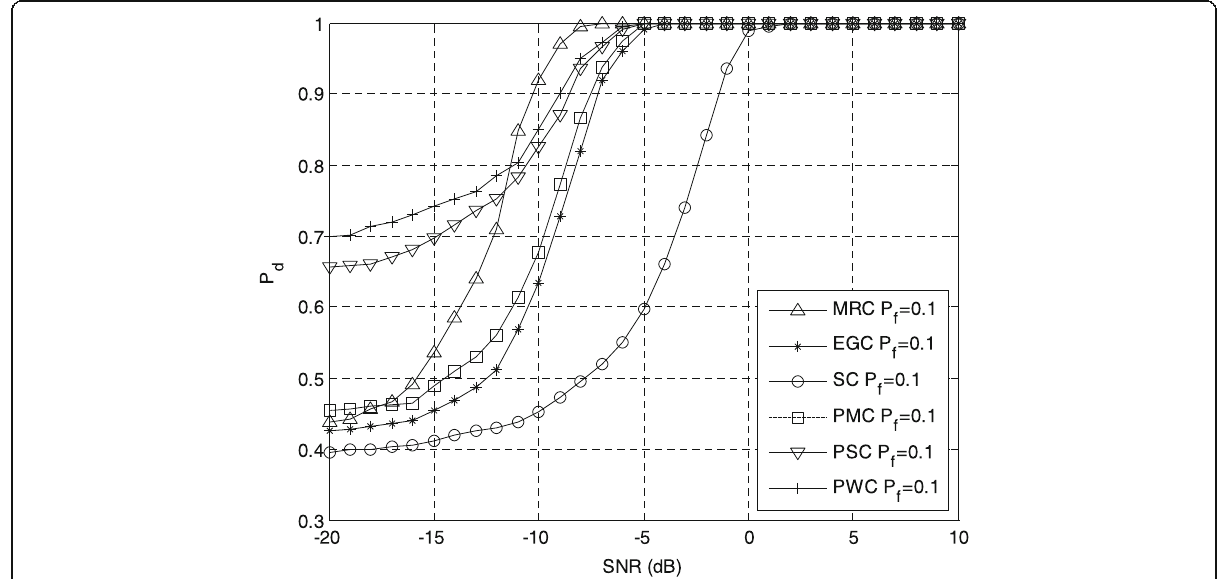
Fig. 9 Performance comparison of the pre-combining detection algorithm and proposed combining algorithm when P f =